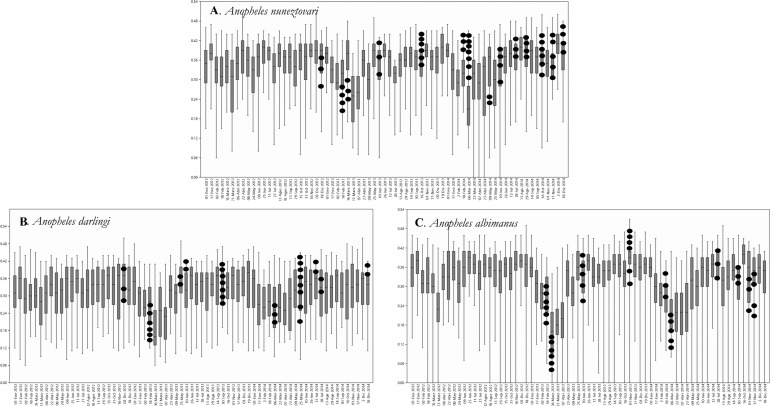
NDVI values at all occurrence sites for the three malaria vectors in northern Colombia.The black dots represent specific NDVI values corresponding to mosquito collection dates.